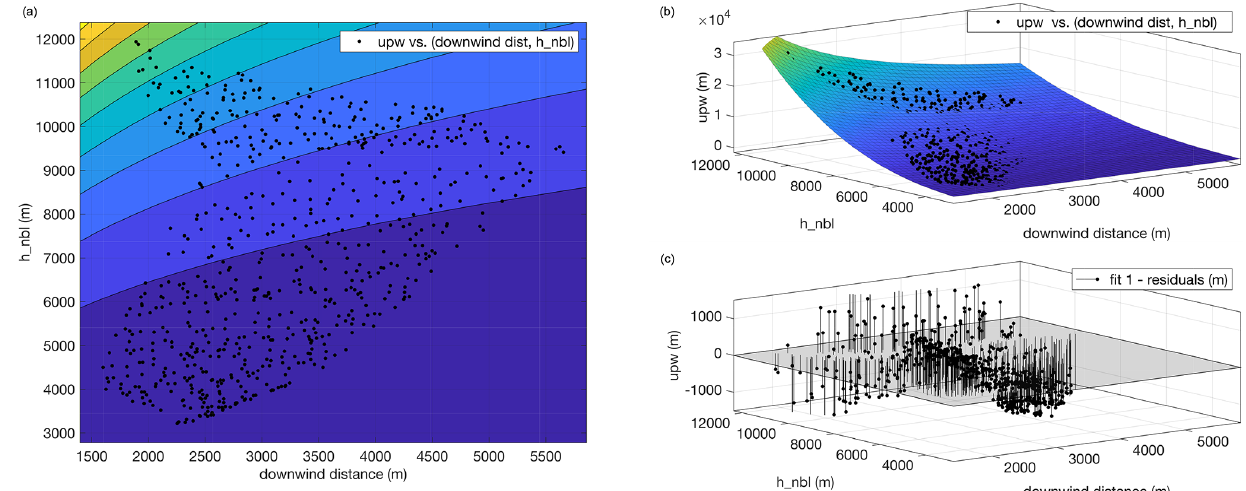
Figure 13. Exponential fitting of upwind spreading vs. neutral buoyancy level height and downwind displacement of the plume axis at the same height. A contour plot is shown in panel (a) , while on the right 3-D views of the fitting surface (b) and the residuals of the fitting (c) are shown. The black dots in panels (a–c) represent PLUME-MoM-TSM